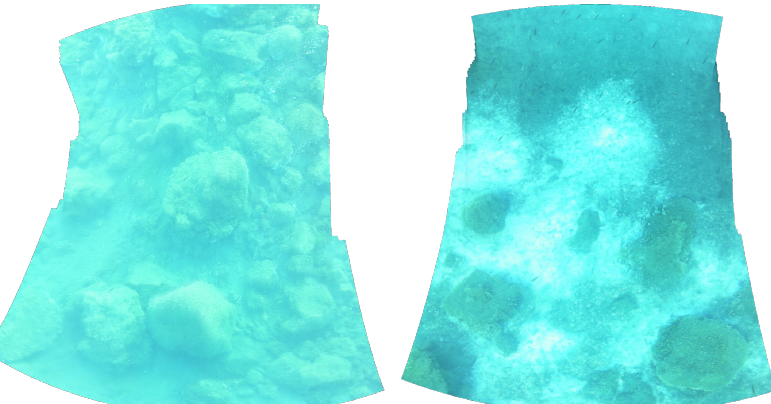
Figure 6. Two opto-mosaics taken from the mission area. On the left, a portion of the seabed covered with rocks of different shapes and dimensions is pictured. Conversely, on the right, the mosaic shows a flat seabed with few rocks and Posidonia oceanica on the top